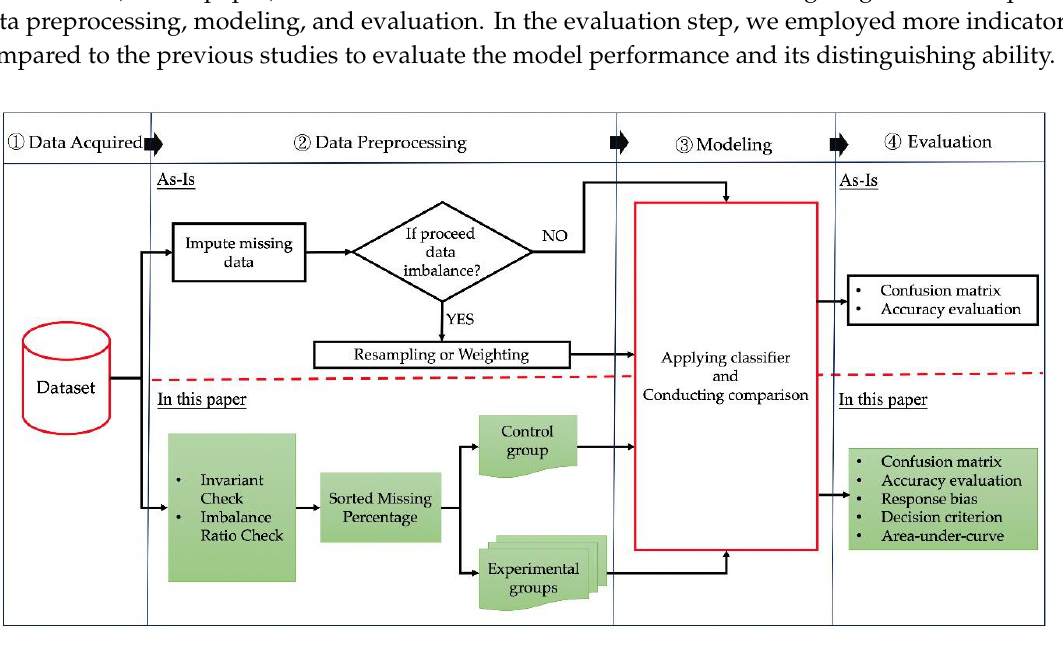
Figure 1. Workflow of the machine learning modeling.